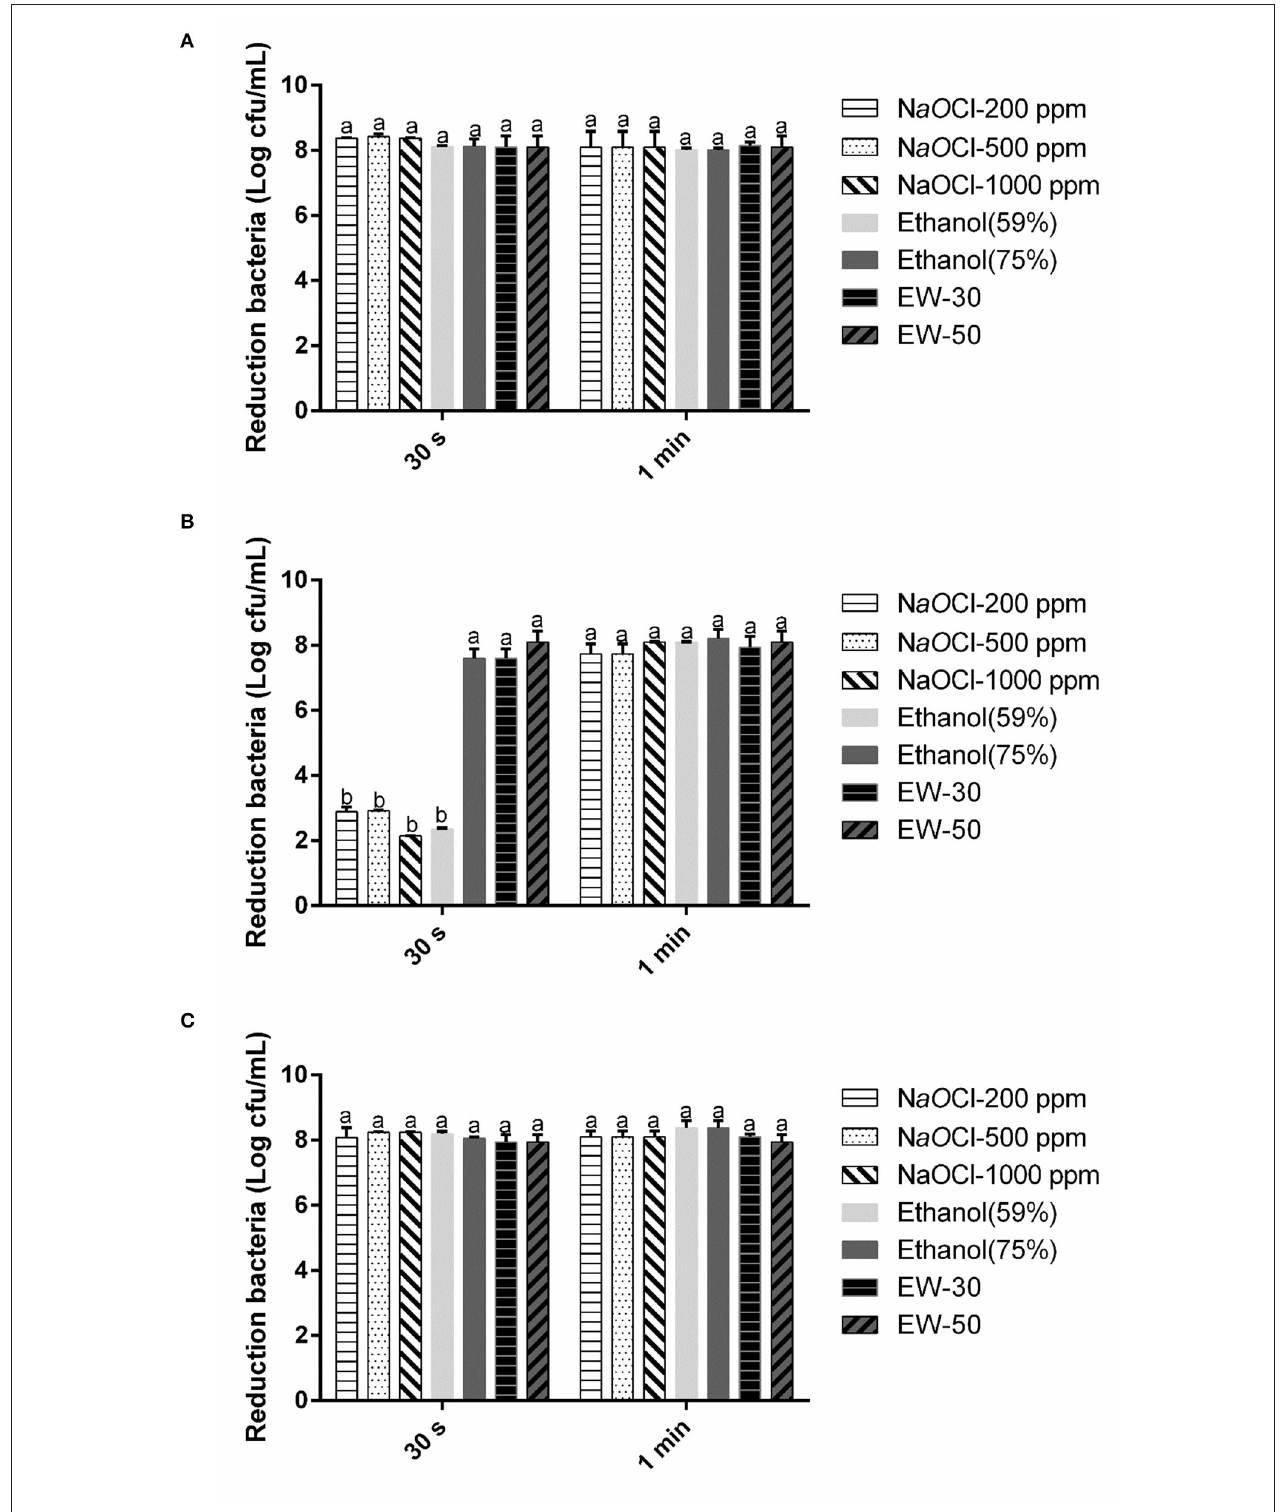
FIGURE 1 | Effect of SAEW, sodium chlorite, and ethanol on E. coli (A) , B. cereus (B) , and S. aureus (C) . NaOCl, sodium chlorite. Error bars indicate the standard deviations of three measurements, and the different letters represent the significant difference ( p ≤ 0.05).